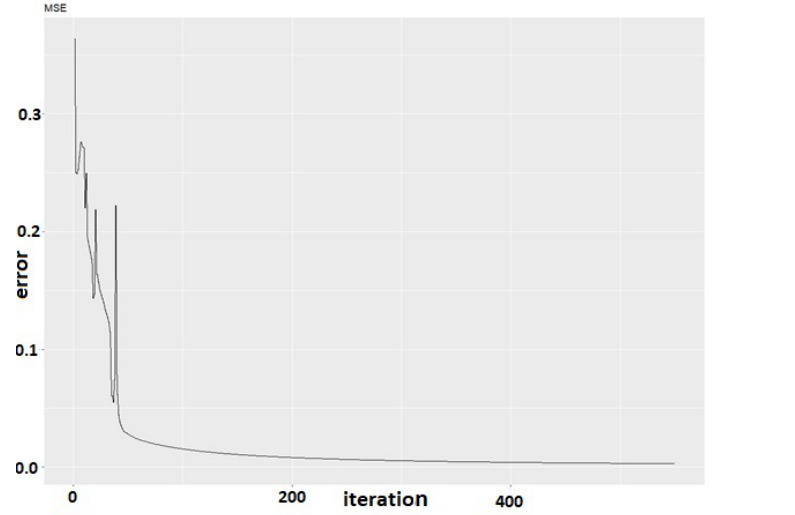
Figure 13. Fuzzy network 3—learning process.